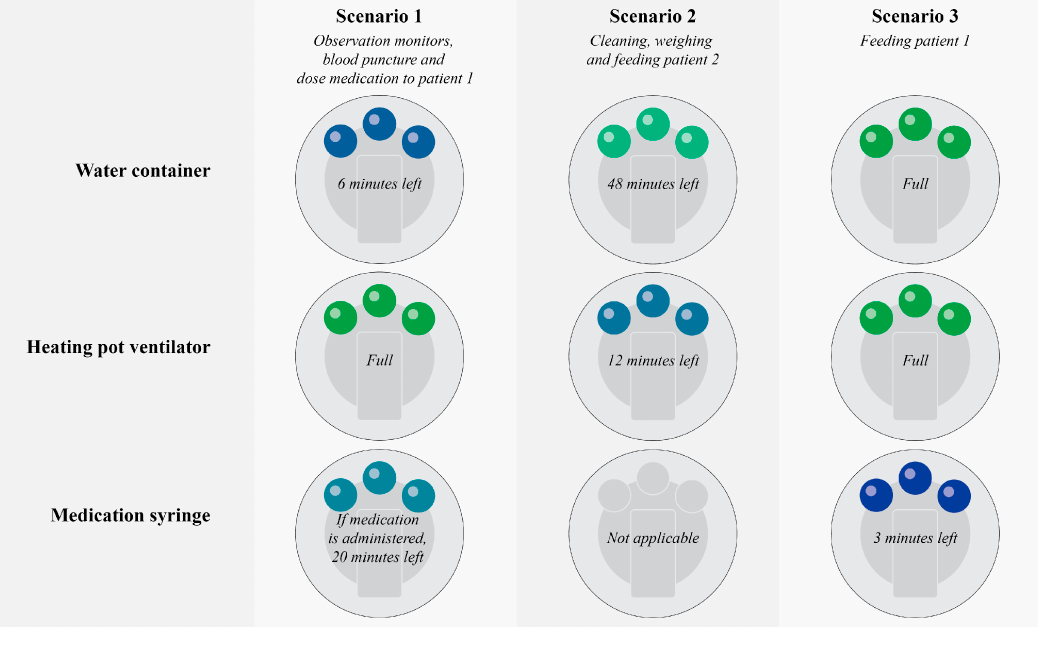
Figure 4. Scenarios and statuses CheckMates.